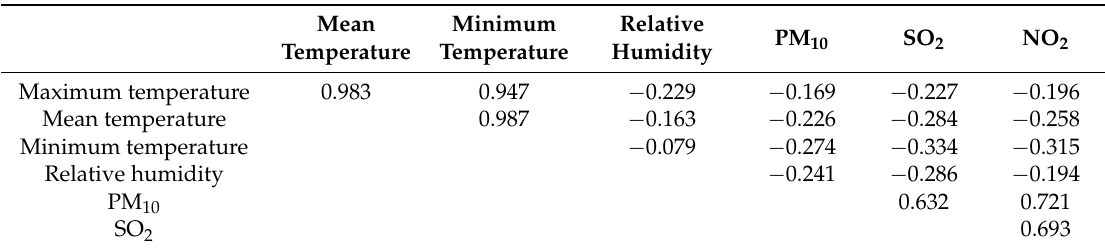
Table 2. Spearman’s correlation coefficients of weather conditions and air pollutants in Jiang’an District of Wuhan, China, 2003–2010 *.